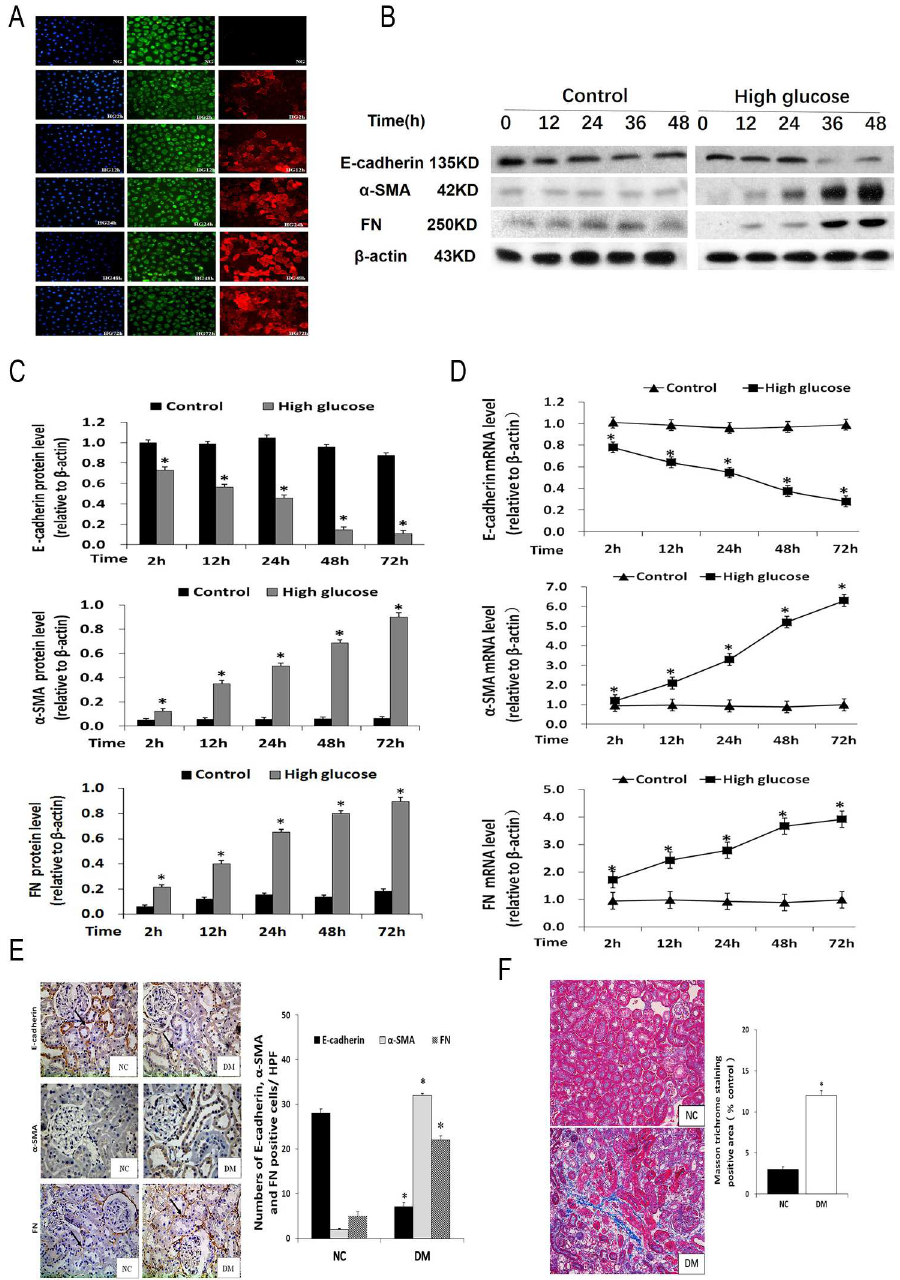
Fig 2. High glucose stresspromotesthe expression of EMT related genesin renal tubular cells and a rat diabetic model. A, E-cadherin (green)and α -SMA(read)levelsin NRK52Ecellsassessedunderaninverted fluorescence microscope(blue:nucleus)(200 × ). B, C, E-cadherin, α -SMA and FN proteinamountsdetermined by Western blotin NRK52Ecells treatedwith 25mmol/L glucosefor 2, 12, 24, 48 or 72h. * P < 0.05vs respective NRK52Ecells treatedwith 5.5 mmol/L glucosefor the same time. D, E-cadherin, α -SMAandFN mRNA levels determined by qRT-PCRin NRK52Ecells treatedwith 25 mmol/Lglucosefor 2, 12, 24, 48 or 72h. * P < 0.05, vs. respectiveNRK52Ecells treatedwith 5.5 mmol/L glucoseat 2h. E, E-cadherin, α -SMAandFN protein expression levelsin kidneytissuesassessedby immunohistochemical staining(400 × ).Data are represented as the means ± SDs(n = 6). * P < 0.05, vs. respectivenormalcontrolgroup. F, Photomicrographsillustrating Masson trichromestainingof kidneytissue (400 × )andthe Massontrichrome–positivetubuleinterstitial area(blue) relativeto the wholeareafrom ten randomcorticalfields was analyzed.Data are representedas the means ± SDs(n = 6). * P < 0.05, vs. respective normalcontrolgroup. Notes :NC, controlgroup;NG, normalglucose group;HG2-72h,highglucose(2h, 12h, 24h,48h, and72h)group;DM, diabetesgroup.